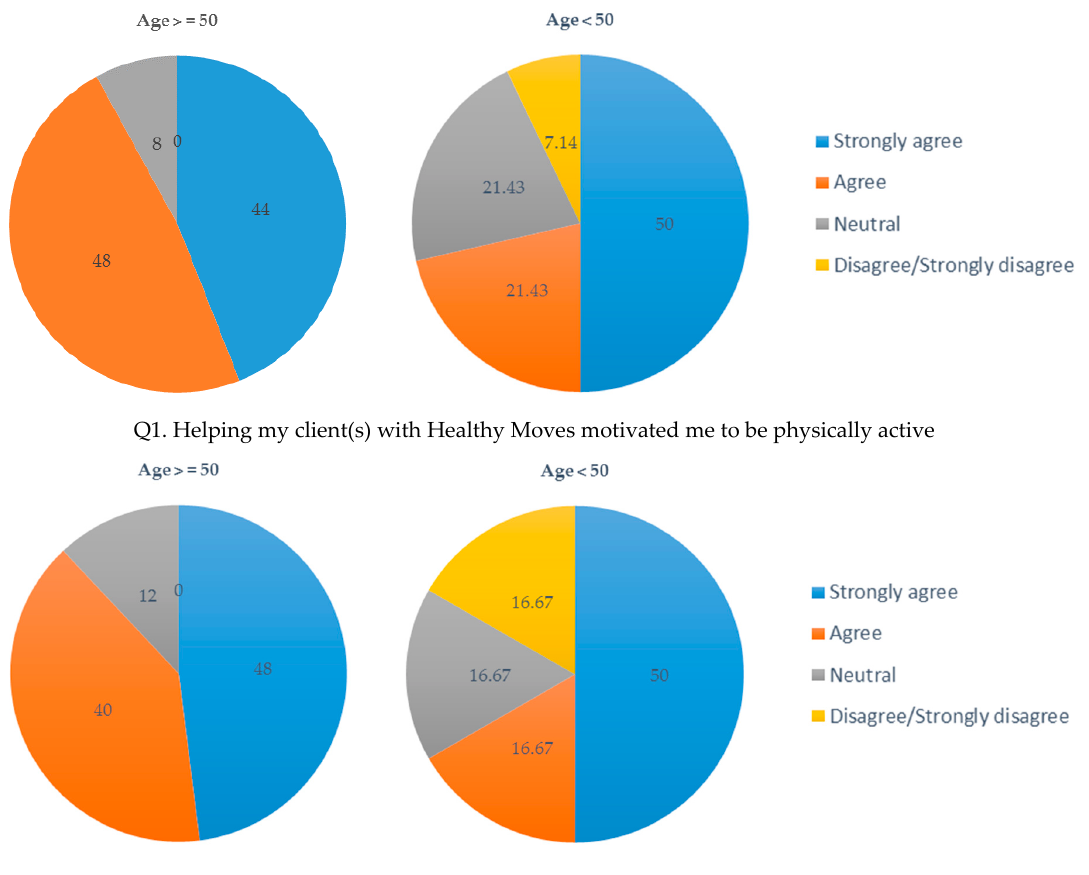
Figure 2. HCAs’ perception of how Healthy Moves impacted their own physical activity (percent).